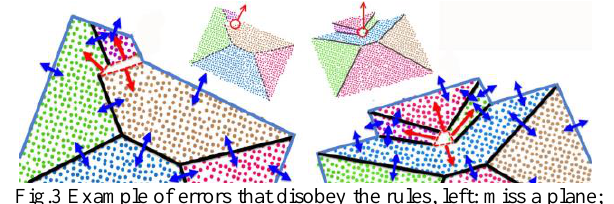
Fig.3 Example of errors that disobey the rules, left: miss a plane; right: miss a ridge (marked by red arrows and arcs).